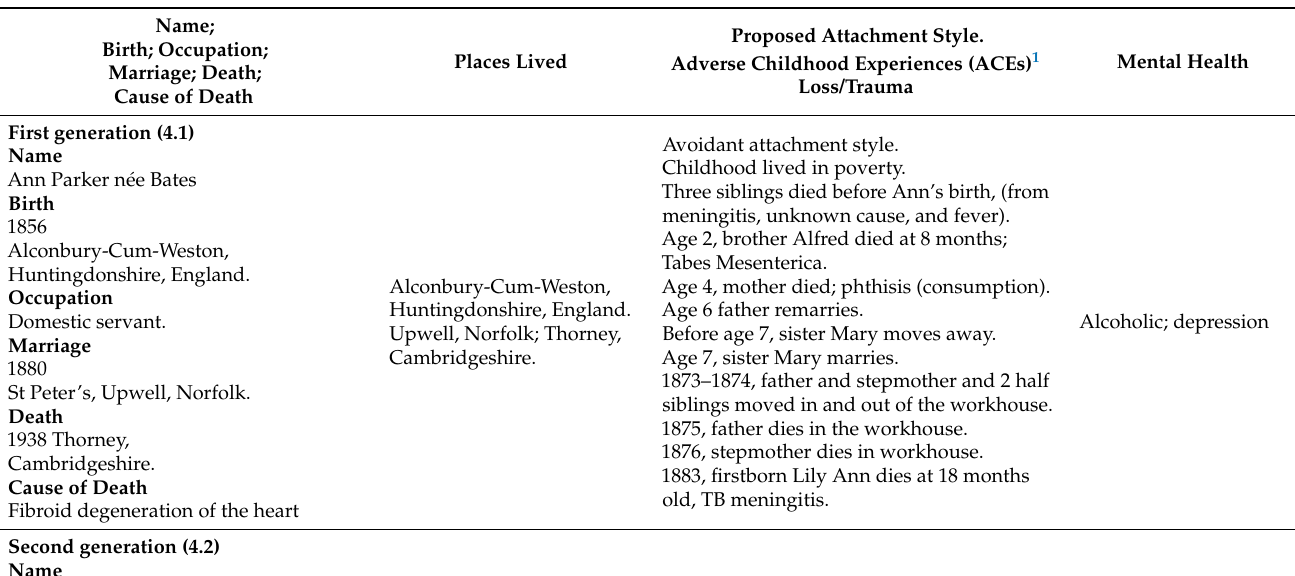
Table 1. Summary of three generations of the Parker